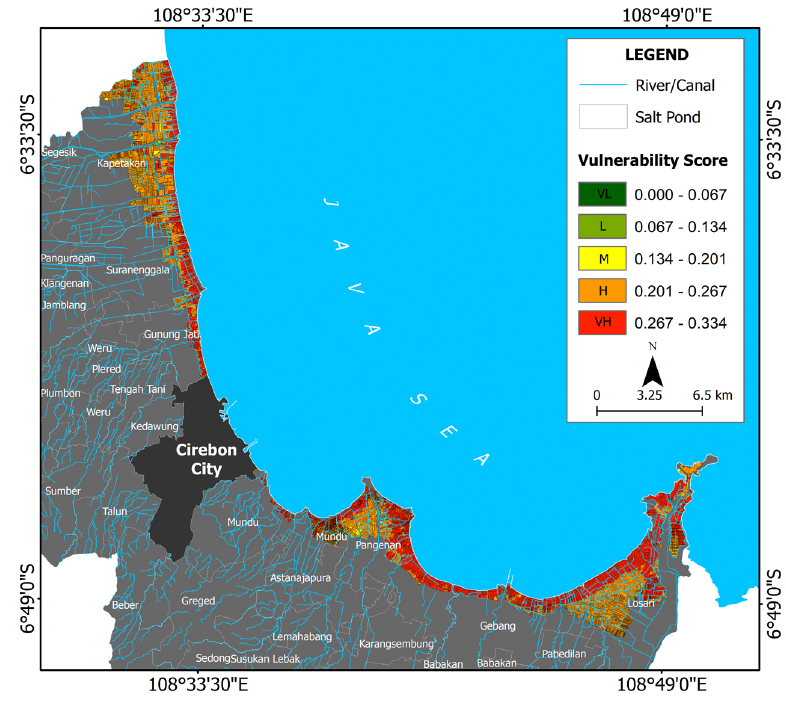
Figure 6 . Vulnerability score represented in a map that is based on multi-criteria input. Figure 6. Vulnerability score represented in a map that is based on multi-criteria